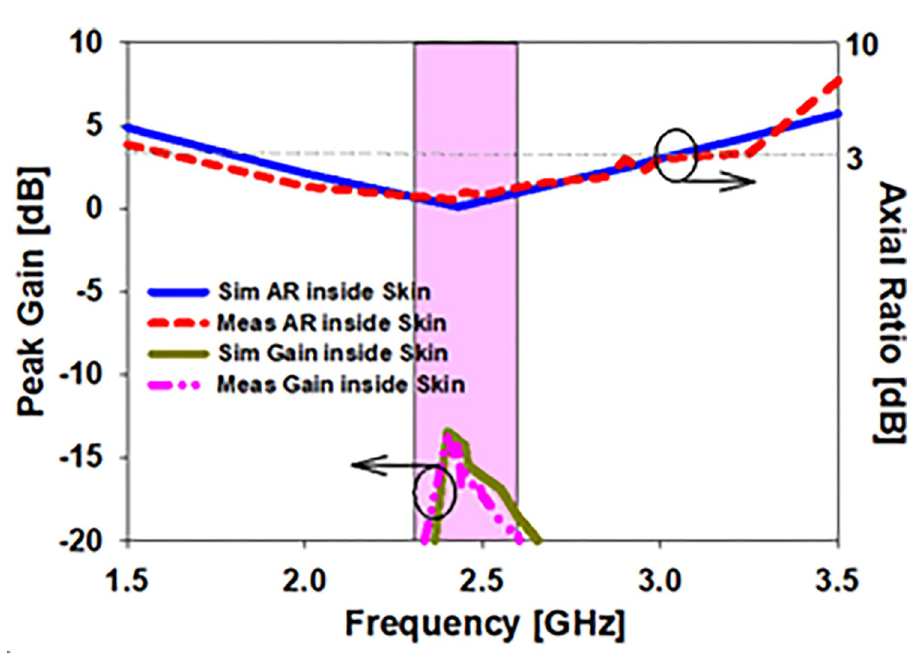
Fig 19. The axial ratio of the prototype printed antenna within skin is compared to the simulation and test gains.